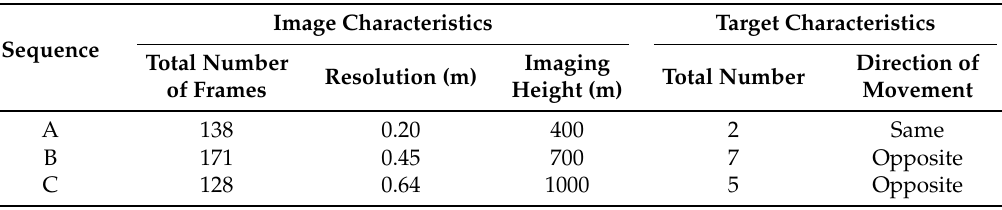
Table 1. Specification of experimental